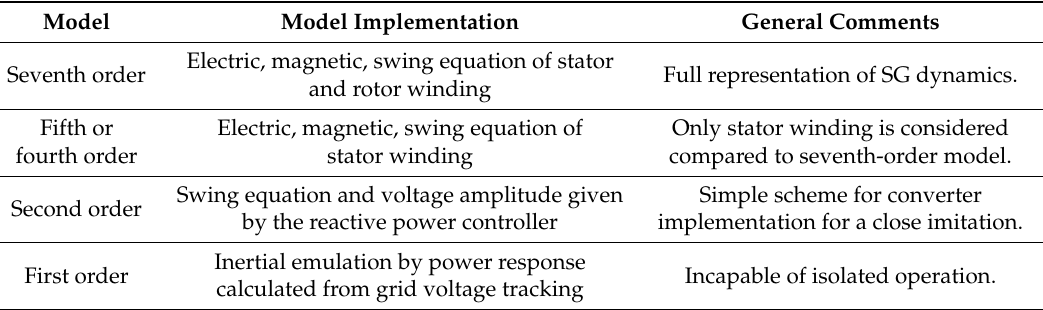
Table 1. Classification of VSG modeling. SG: synchronous